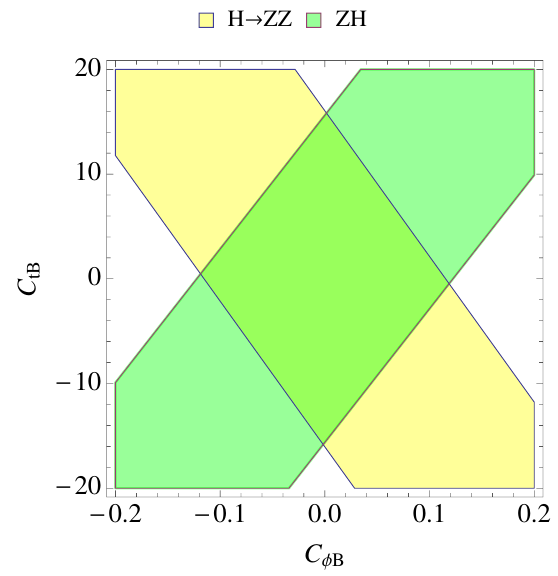
Figure 8 . Constraining both C tB (top operator, loop level) and C ’B (Higgs operator, tree level) by combining H ZZ (cid:3) and ZH production, assuming 1% precision on both. (cid:22) EFT = 125 GeV. ! (cid:3) = 1